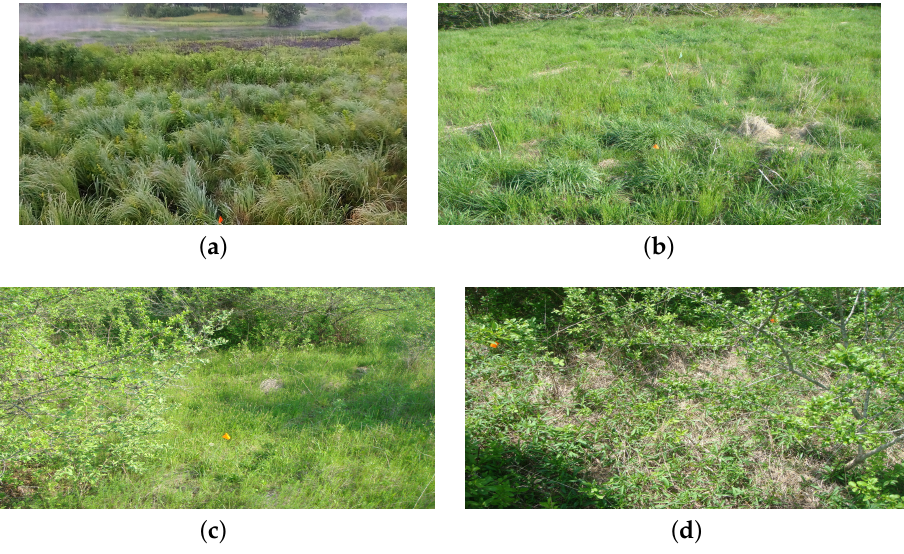
Figure 2. Examples of early-stage community plots from ( a ) Lake Arnold; ( b ) the northeast boundary;